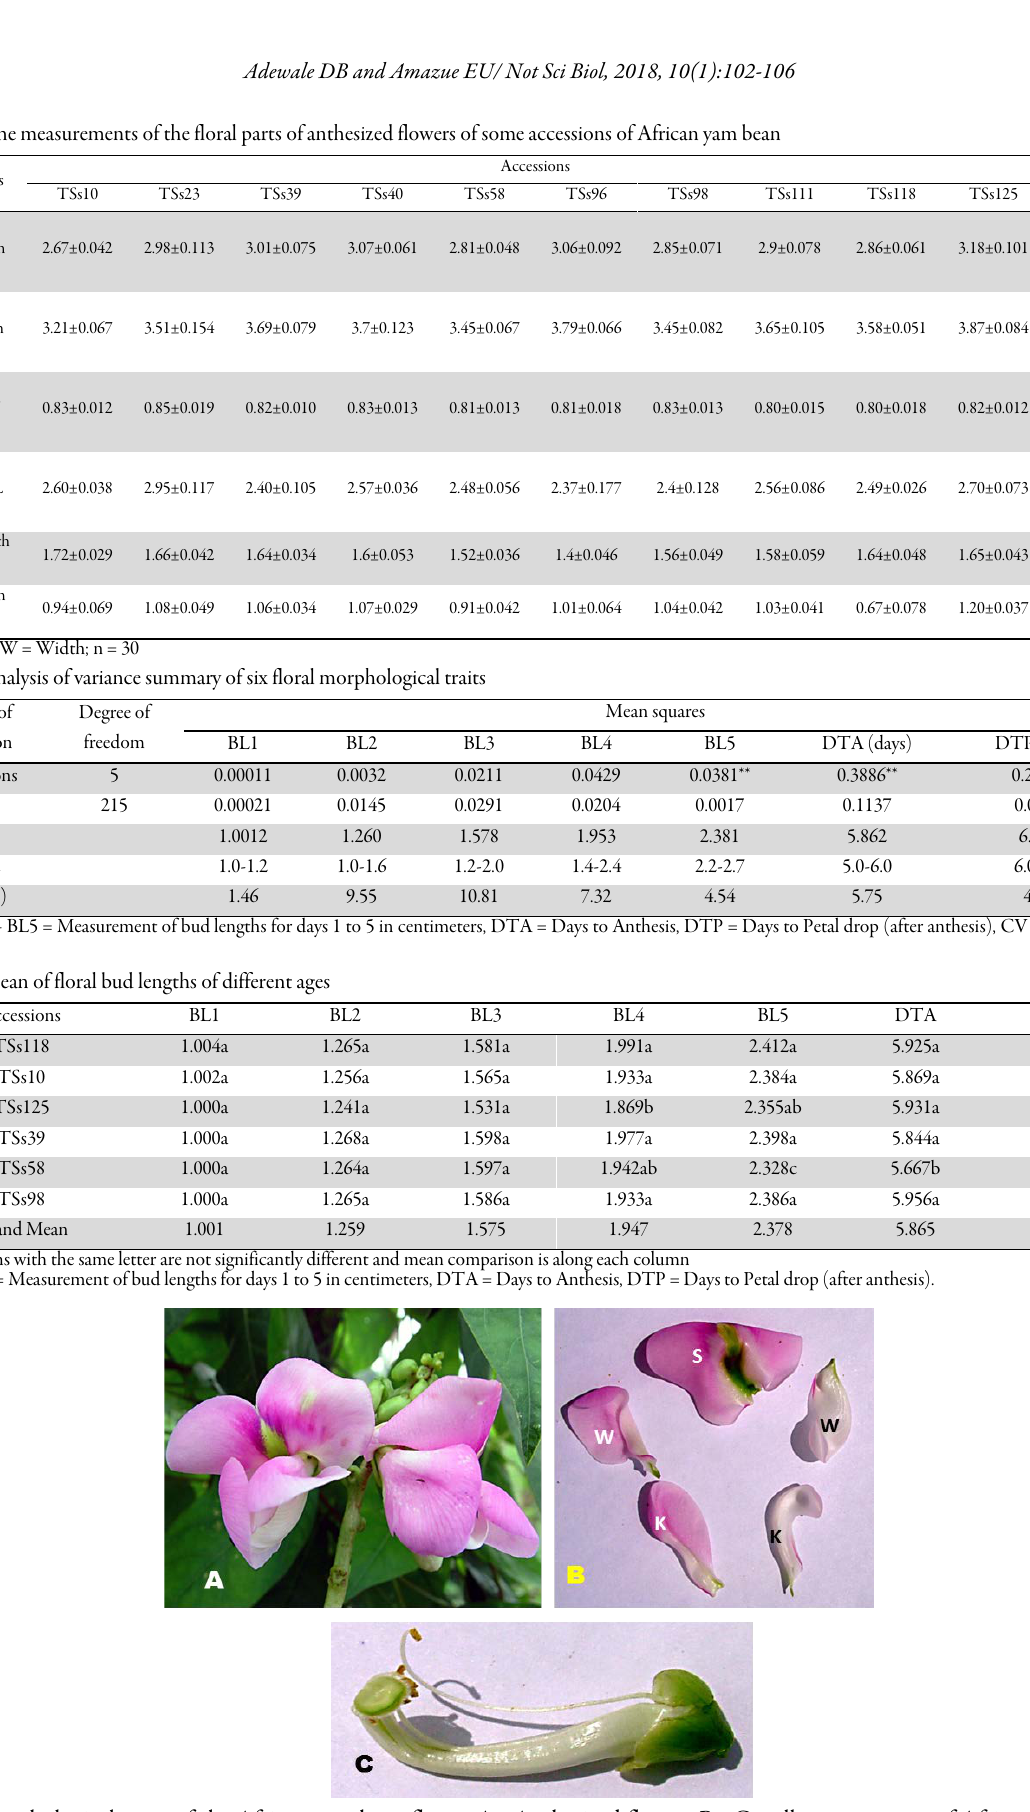
Fig. 1. Morphological parts of the African yam bean flower A - Anthesized flower; B - Corolla components of African yam bean (S - Standard/banner, W - Wings (2) and K - Keels (2)); C - Diadelphous stamens (nine filaments fussed from base and one free, each bearing one anther) and “ sphen ” (Greek) e.g. dorsiventrally flattened ovary and wedge or cuneate